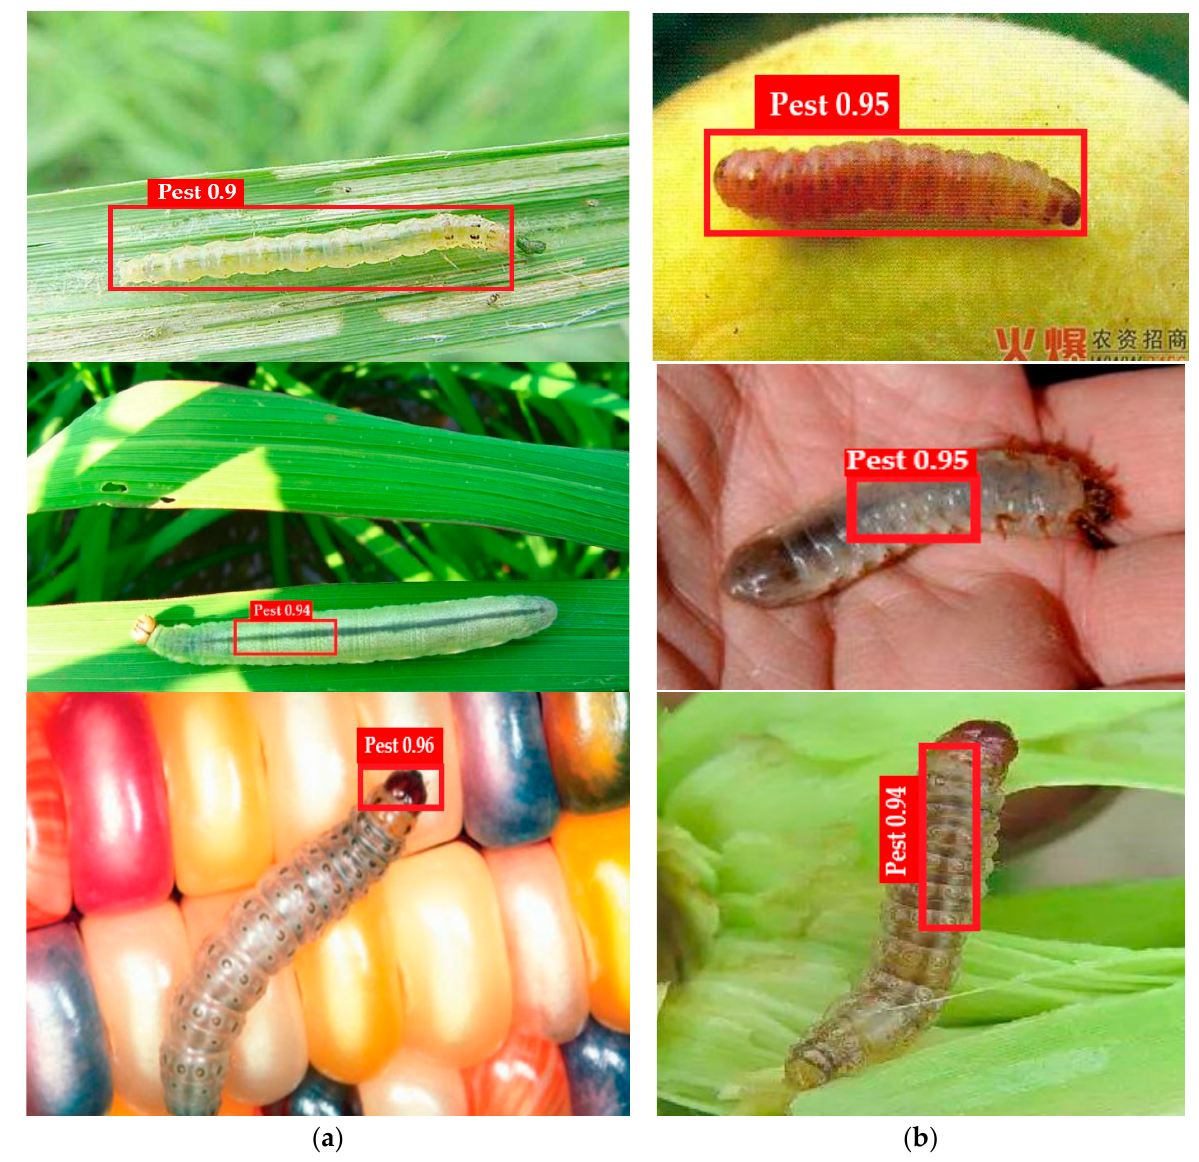
Figure 4. ( a , b ) Shows the proposed method localization results.